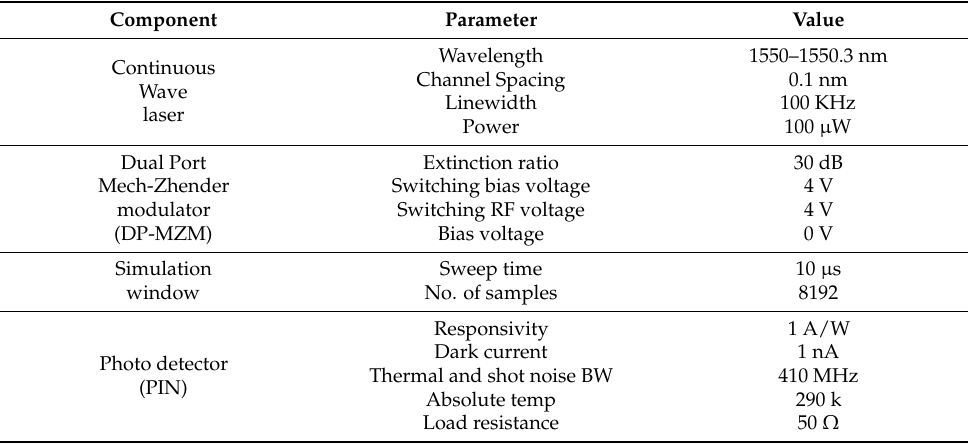
Table 1. Photonic Radar Modeling